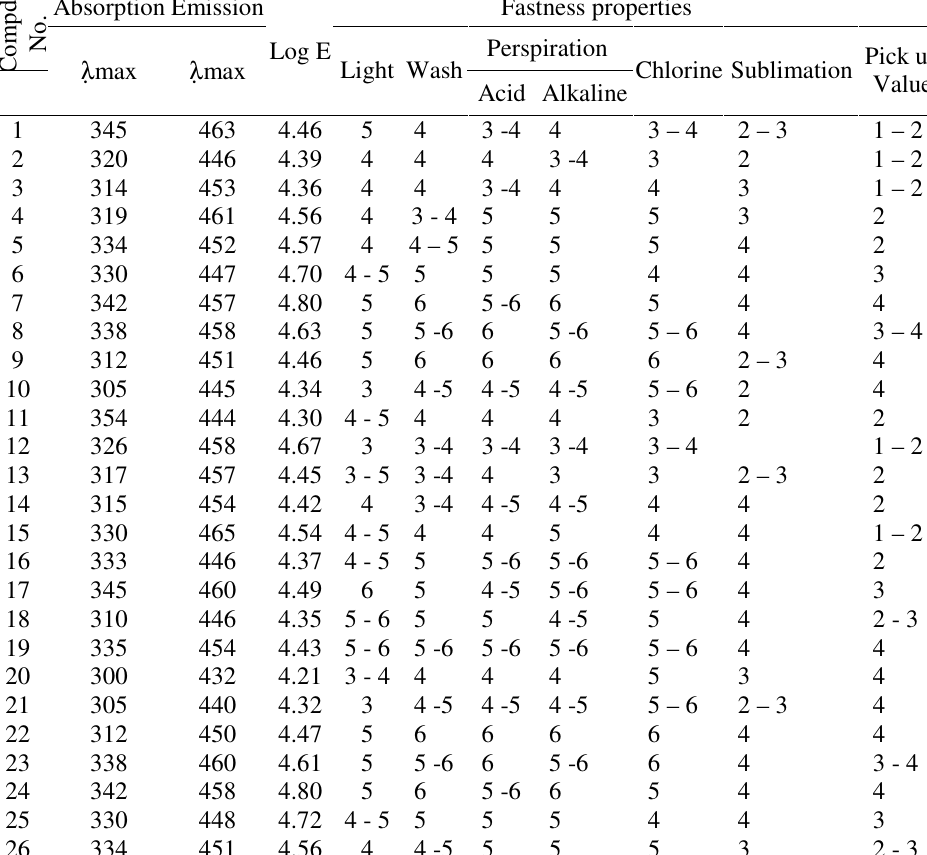
Table 2. Absorption – Emission and Fastness Evaluation Data of the compounds 1 – 26. Absorption